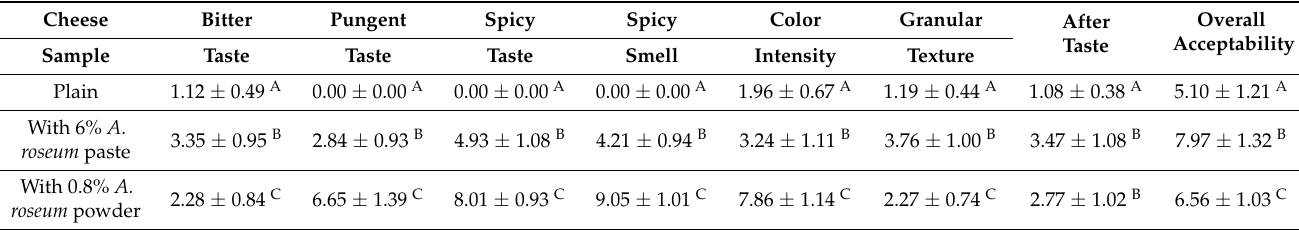
Table 1. Scores of sensory attributes for the scoring test (linear scale) of plain and flavored double cream cheeses with Allium roseum paste and